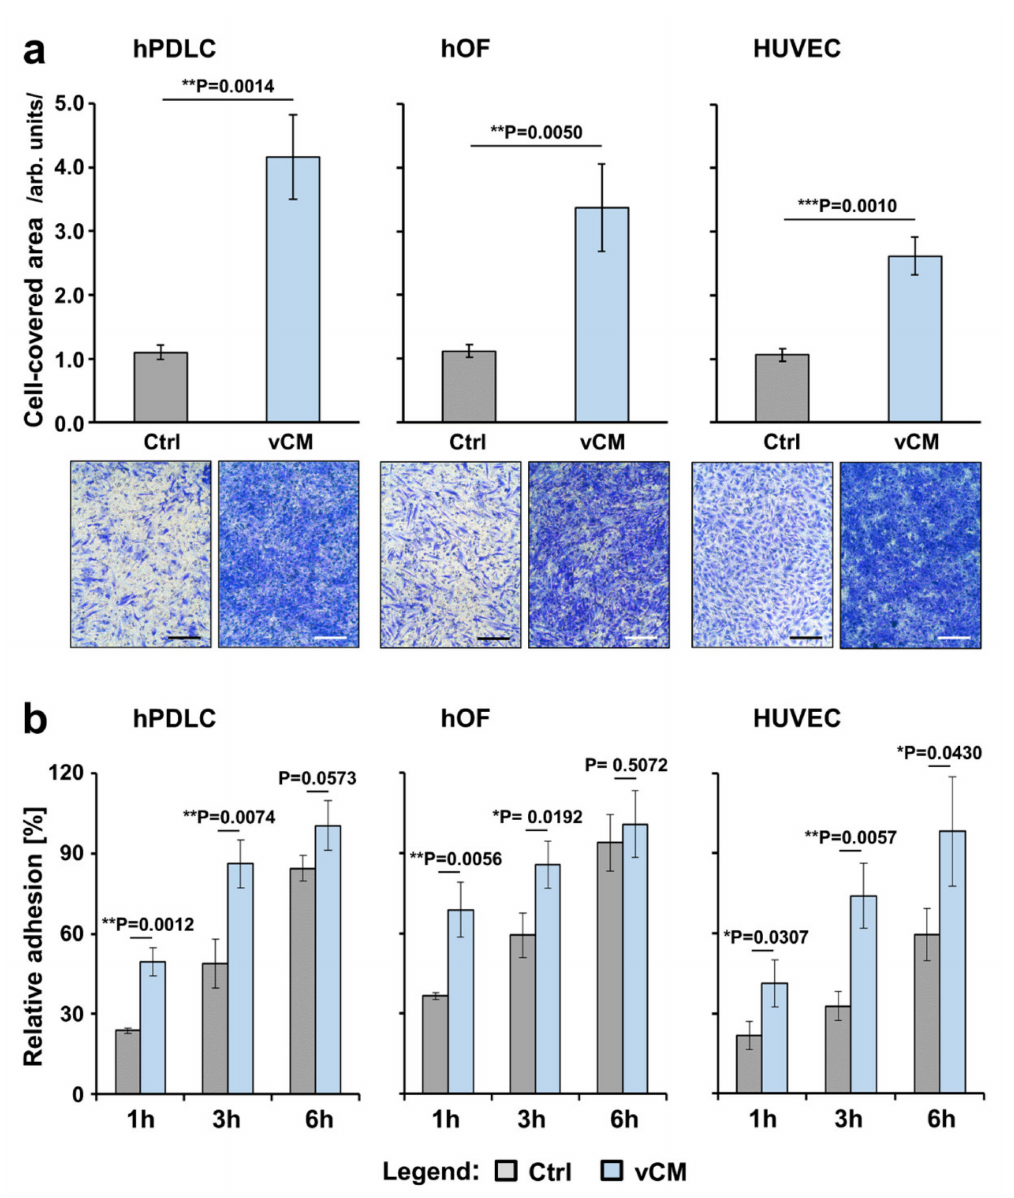
Figure 1. Promigratory ( a ) and proadhesive ( b ) effects of vCM on three primary cell types of human origin. ( a ) Migratory capacity of hPDLCs (left panel), hOFs (middle panel), and HUVECs (right panel) toward vCM was examined by modified Boyden chamber assay using cell culture inserts with permeable membranes (8 µ m pore size). Following an incubation period of 18 h, cells that had migrated through the membrane were stained and quantified by using ImageJ. Cells that migrated in the absence of vCM served as a control (Ctrl). Means ± SD from three independent experiments performed in duplicates and a significant difference between the control and test group, ** p < 0.01, *** p < 0.001 are shown; Representative images of crystal violet-stained cells in each of the experimental groups are shown below the bar charts. Scale bar, 500 µ m. ( b ) Adhesive capacity of hPDLCs (left panel), hOFs (middle panel), and HUVECs (right panel) on vCM was examined using crystal violet staining of adherent cells at 1, 3, and 6 h postseeding. Controls (Ctrl) represent cells of each cell type seeded on tissue culture-treated plates in the absence of vCM for the indicated times. Normalization of the experimental values to the values obtained for the total number of seeded control cells (taken as 100% adhesion) was applied. Means ± SD from three independent experiments performed in duplicates and significant differences to control cells at each time point, ** p < 0.01, * p < 0.05 are